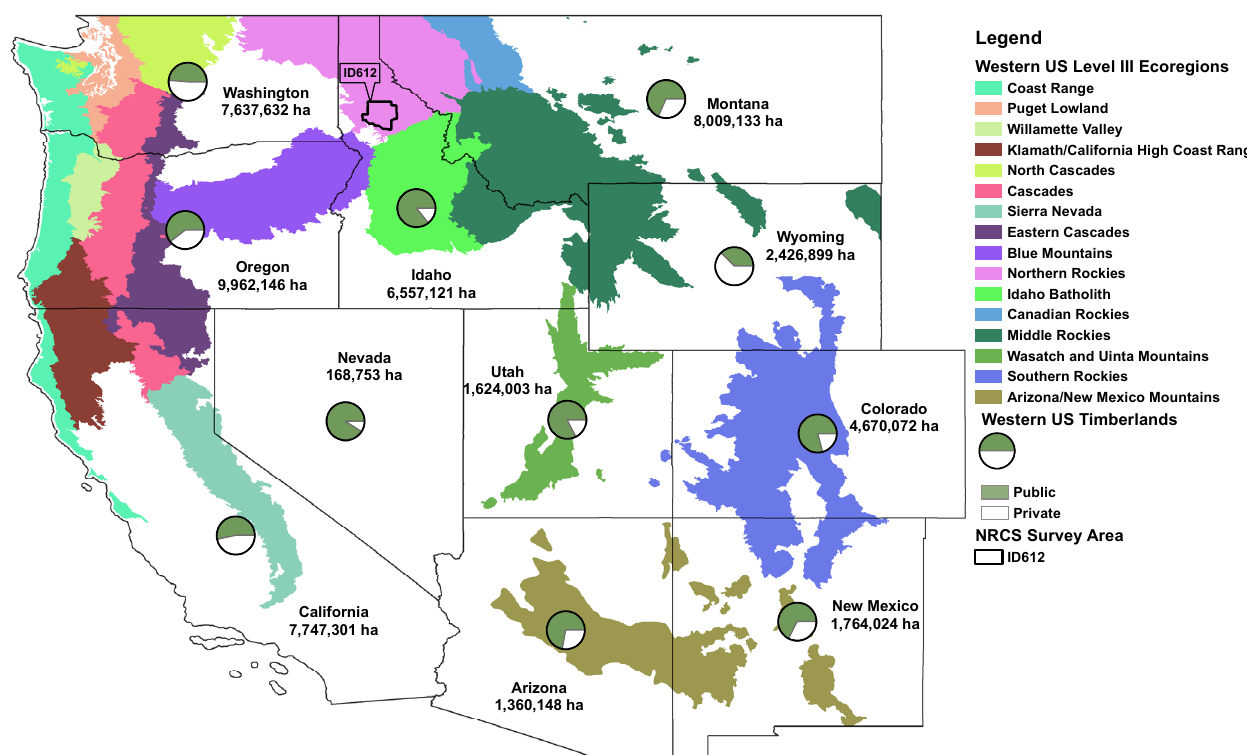
Figure 1. Forested ecoregions across the western US and the proportion of timberlands held by private and public forest landholders (pie charts). Text reflect the hectares of timberland in each state. The Natural Resource Conservation Service (NRCS) soil survey area—ID612—denotes the area of interest for this